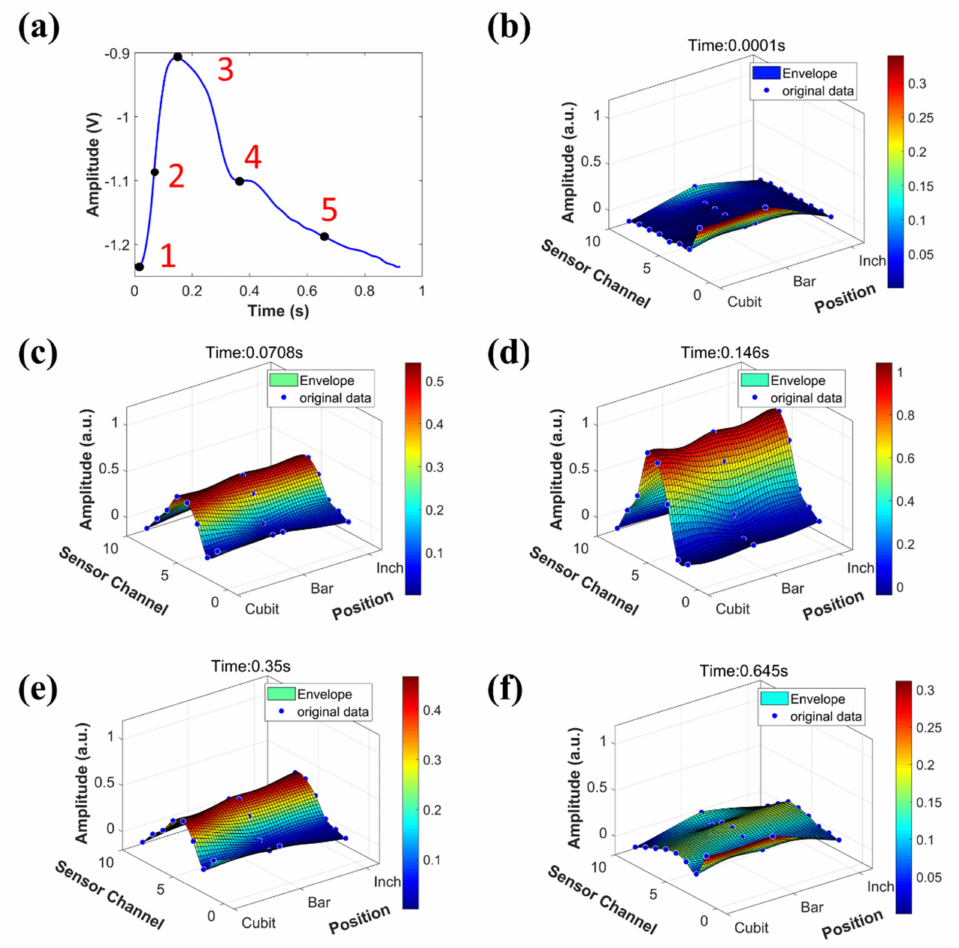
Figure 11. 3D pulse envelope images at different timestamps. ( a ) One cycle pulse waveform was collected from the cubit position. ( b – f ) are the 3D pulse envelope images at the corresponding time points of 1, 2, 3, 4, 5 in the curve of ( a ),